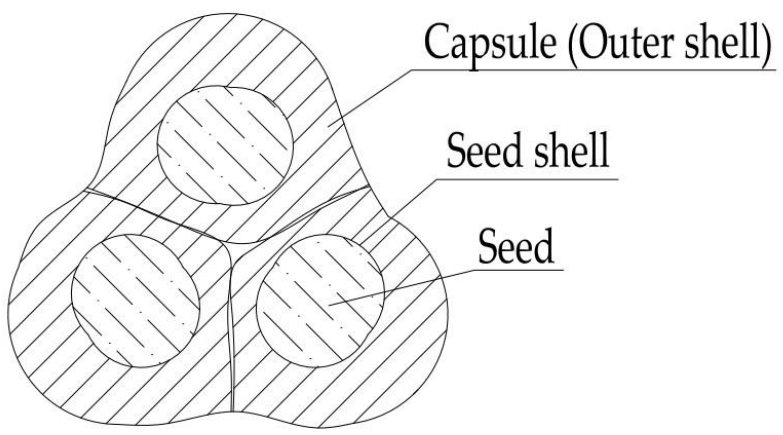
Figure 1. The assembly of the fruit of the RT.